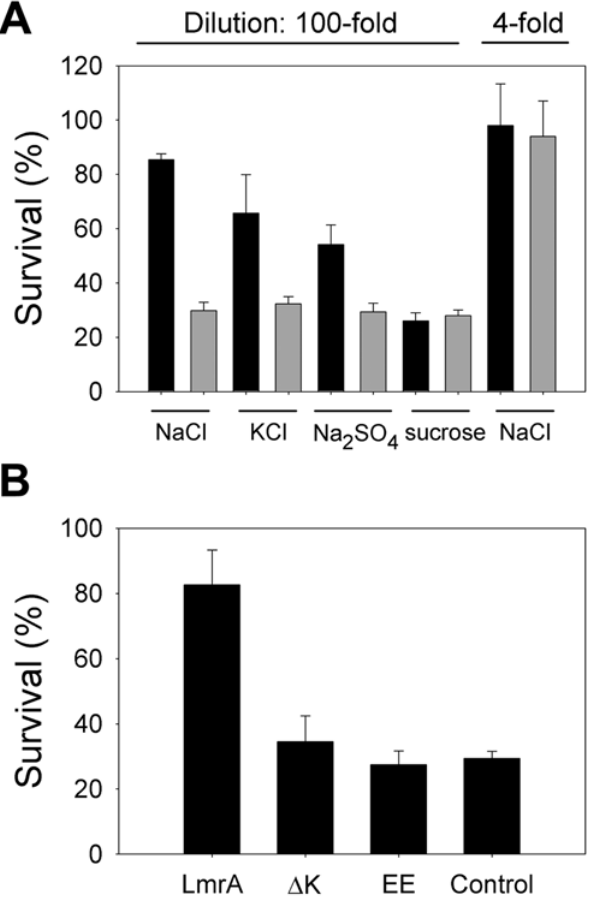
Figure 5. LmrA activity enhances cell survival. A, Viability of energized cells (solid bar, LmrA; grey bar, non-expressing control) adapted for 30 min in buffer containing 0.5 M sucrose without or with 100 mM NaCl, 100 mM KCl or 50 mM Na 2 SO 4 , followed by 100-fold dilution into ultrapure water, or in buffer containing 0.125 M sucrose and 25 mM NaCl (control referred to as 4-fold dilution). B, Effect of mutations in LmrA on the viability after dilution of cells pre-exposed to 100 mM NaCl plus 0.5 M sucrose under conditions as in (A). ( n